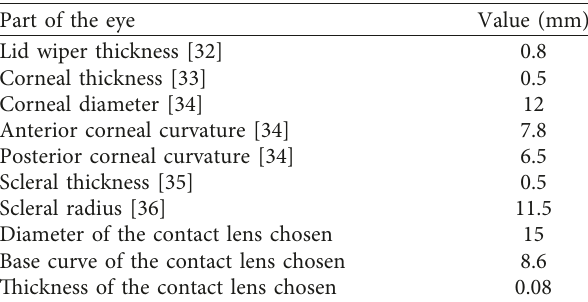
Table 1: Dimensions of ocular structures and contact lens used in the finite element